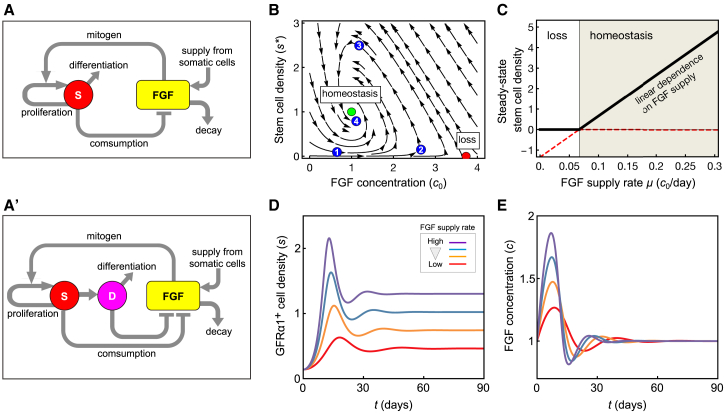
The Mitogen Competition Model(A and A′) Feedback diagrams of the “mitogen competition” model, showing the mutual regulation of the stem cell density and FGF abundance; (A) case in which only stem cells (“S”) consume FGF; (A′) case in which, in addition, the differentiation-destined progenitors (“D”) also consume FGF.(B) Phase portrait showing the dynamics of stem cell density and FGF concentration in the mitogen competition model. The system possesses two fixed points: a homeostatic state (green dot) and a loss state (red dot). For the shown parameter set, only the homeostatic state is stable, as all trajectories obtained by following the arrows converge toward this state (e.g., the trajectory indicated by numbered dots). Here, c0 is the threshold FGF concentration at which duplication and loss by differentiation exactly balance; the steady state is set at a stem cell density s∗=(μ−kc0)/k' and c∗=c0 (parameters explained in the main text). Blue dots (1–4) are provided to explain qualitatively the model dynamics (see main text). Parameters are given in Table S2.(C) Steady-state stem cell density as a function of the FGF supply rate. Above the critical supply rate, the homeostatic state is stable (shaded area) and the homeostatic stem cell density depends linearly on the FGF supply rate. Below a critical supply rate, the loss state is stable (white area) and stem cell loss is inevitable. Parameters are as in (B).(D and E) Numerical examples of the model simulation showing the GFRα1+ cell density (D) and tissue FGF concentration (E), starting from arbitrary initial conditions. Red, yellow, blue, and purple lines indicate different rates of FGF production (μ/c0=0.15,0.2,0.25,0.3d−1 in this order). All other parameters are given in Table S2.